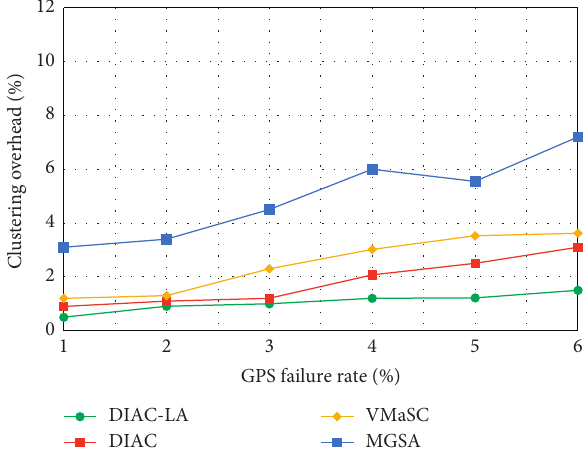
Figure 9: Clustering overhead against a preset GPS failure